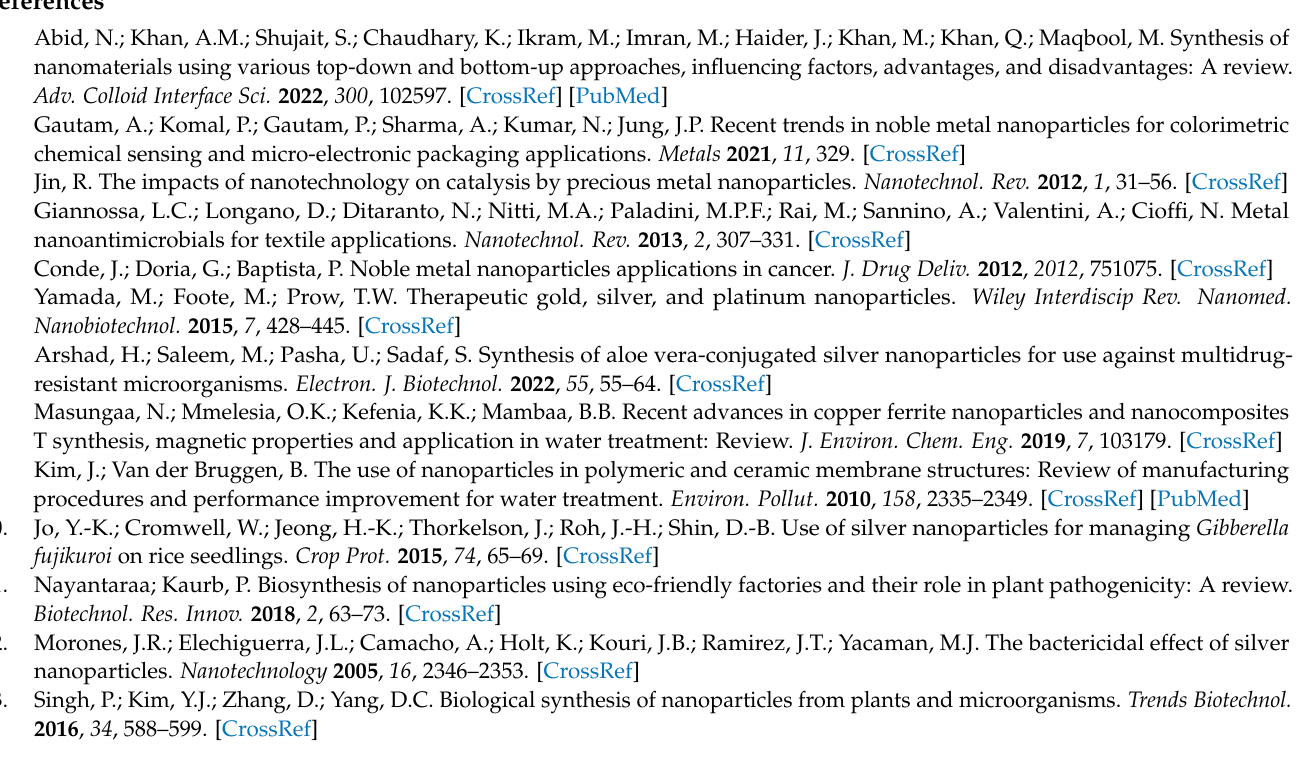
h. Supplementary Figure S2: Dynamic light scattering (DLS) and transmission electron microscopy (TEM) analysis of T. purpurogenus extracellular-pigment-mediated AgNP biosynthesis by light expo- sure at different wavelengths for 24 h. Supplementary Figure S3: Minimum bactericidal concentration (MBC) of biosynthesized AgNPs and streptomycin against S. aureus and E. coli. Supplementary Figure S4: Correlation graph of the logarithm streptomycin concentration and zone of inhibition against E. coli and S. aureus . Data are expressed as the means ± SE (n = 3